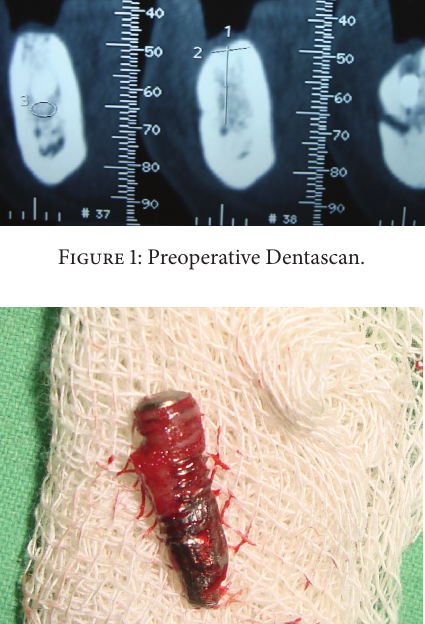
Figure 2: Surgically retrieved implant fragment.